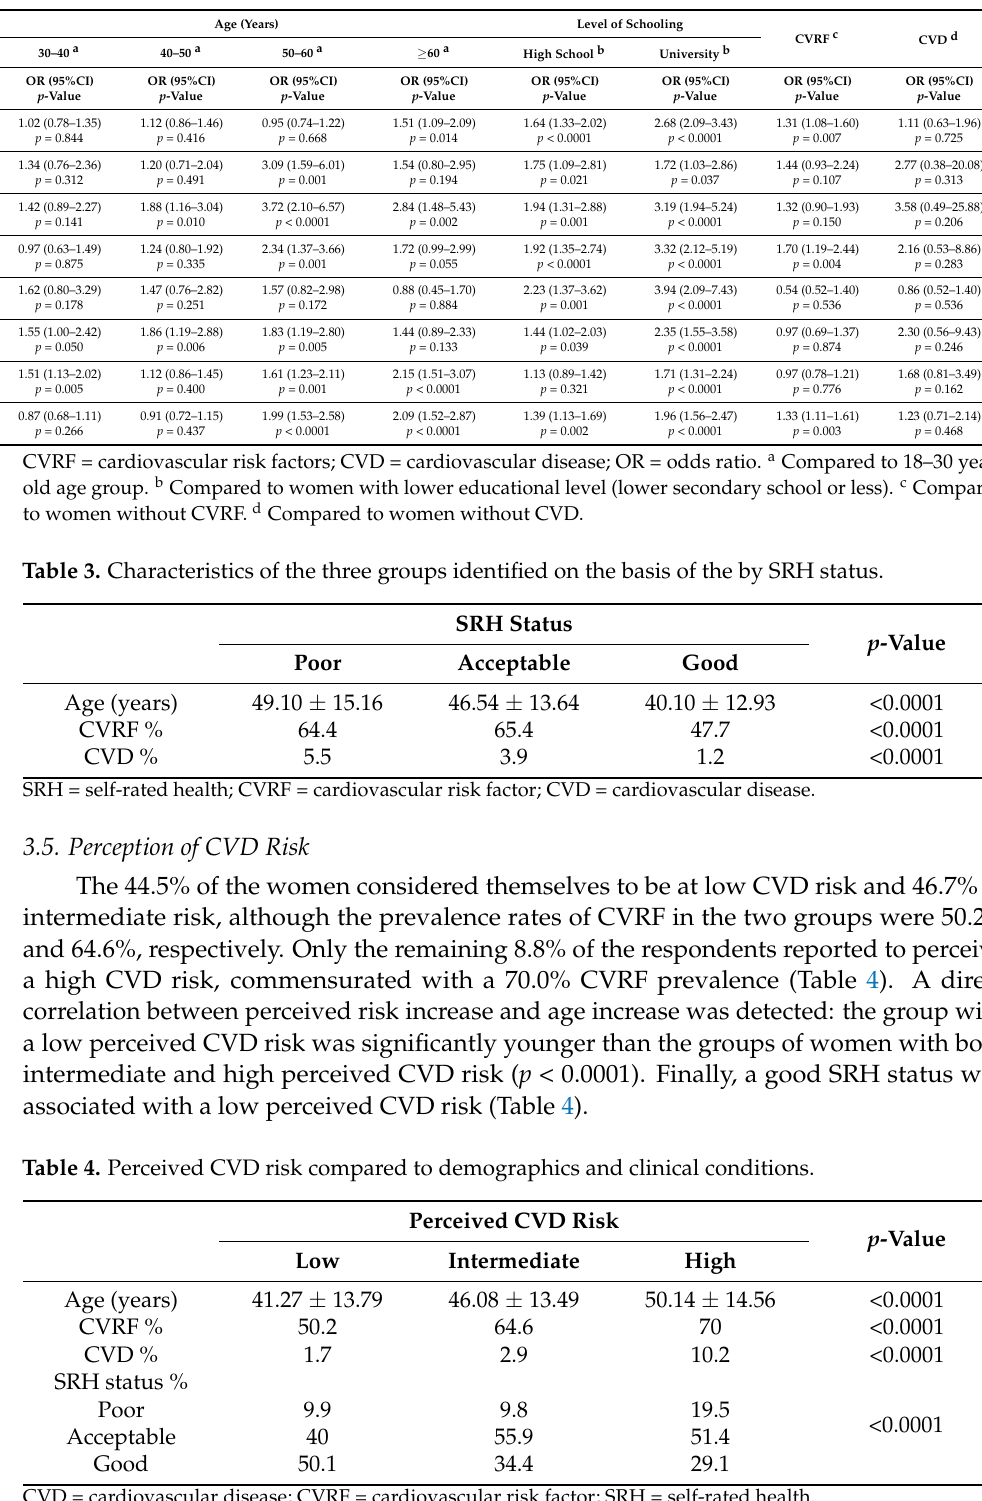
Table 2. Logistic regression for awareness of CVRF.